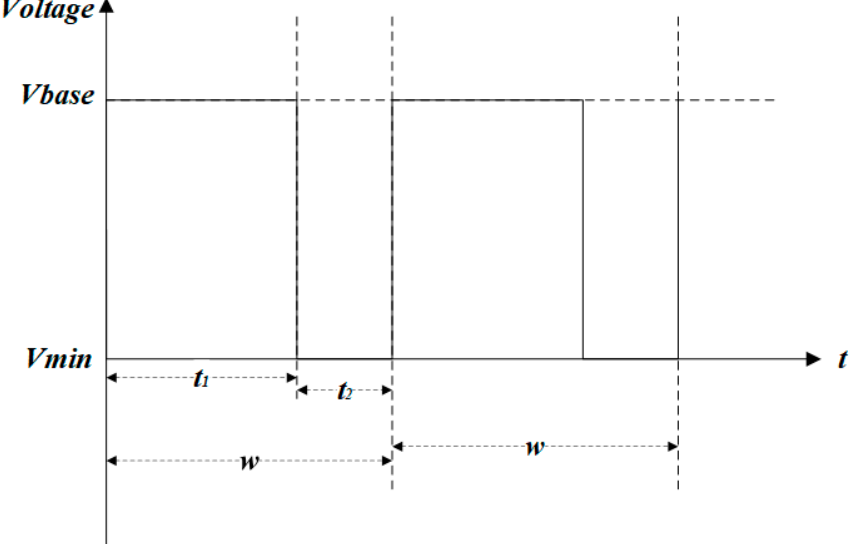
Figure 7. Driving waveforms diagram in a stable driving phase.